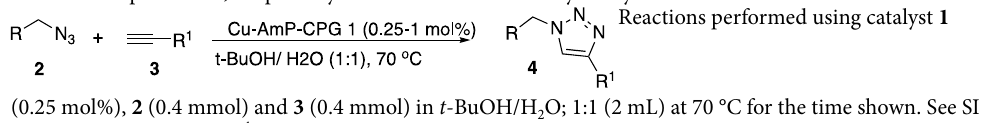
Reactions performed using catalyst 1